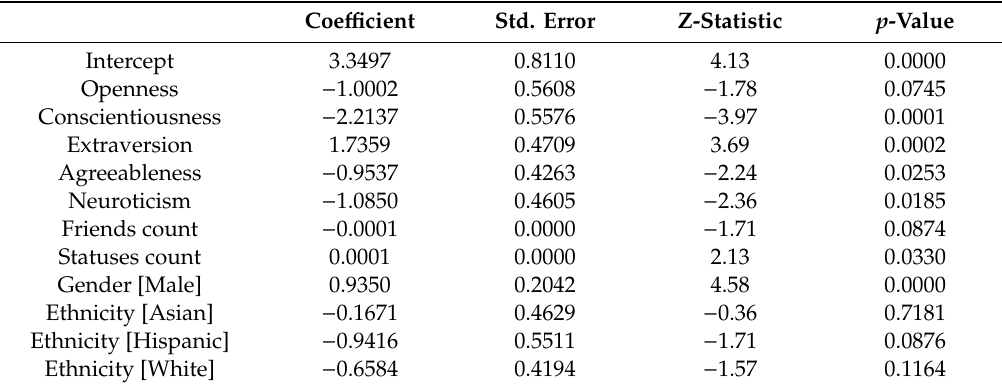
Table 4. Estimated coe ffi cients of the logistic regression